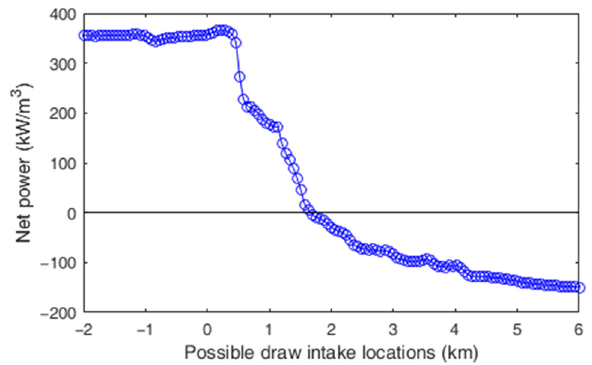
Figure 6. Pumping energy required for draw water taken from different locations (horizontal axis: distance from the end of the river’s channel, with positive distances upstream).